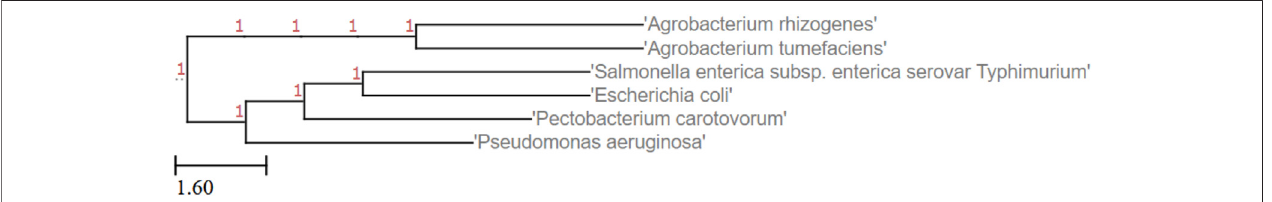
FIGURE 1 | Phylogenic tree of the bacteria used for evaluating the antimicrobial properties of